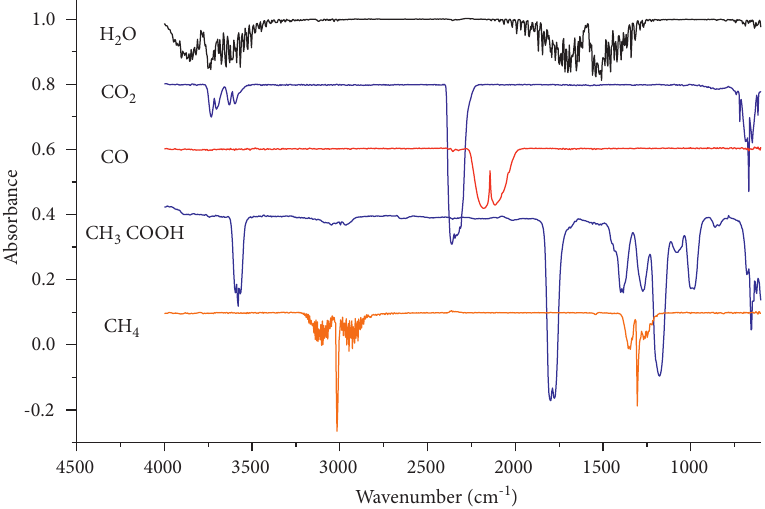
Figure 11: Infrared spectra of reference standard